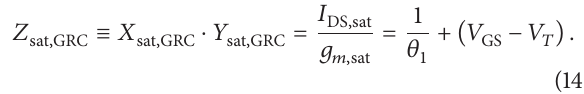
Figure 4: 𝐼 - 𝑉 characteristics measured in the saturation domain and corresponding 𝑌 -functions ( 𝑌 1 and 𝑌 2/3 ) for UTB ( 𝑡 DS GS = 2.2 nm) taken at 𝑉 = 3V and 𝑉 = 7 V, respectively: (a) UTB, 𝑊/𝐿 = 80 𝜇 m/8 𝜇 m, 𝑇 = 300 K. (b) UTB, 𝑊/𝐿 = 80 𝜇 m/8 𝜇 m, and GRC ( 𝑡 SI DS DS 𝑇 = 77 K. (c) GRC, 𝑊/𝐿 = 80 𝜇 m/8 𝜇 m, 𝑇 = 300 K. (d) GRC, 𝑊/𝐿 = 80 𝜇 m/8 𝜇 m, 𝑇 = 77